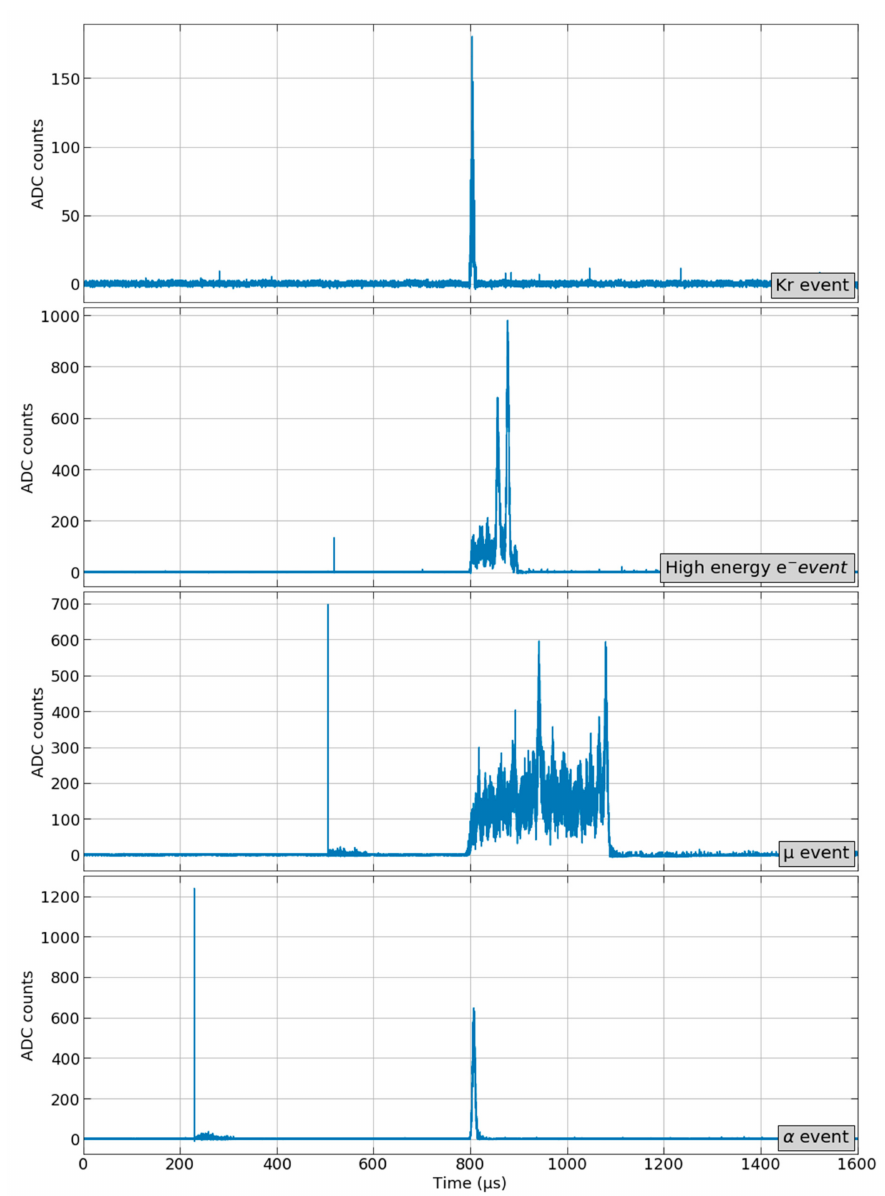
Figure 6. Set of events with a different range of energies from RUN 8250. General configuration: Circular Buffer size of 1600 µ s and pre-trigger of 800 µ s. EVT1 type set for low energy: Maximum amplitude of 1000 ADC counts, minimum and maximum amplitude thresholds of 5000 and 50,000 sum of ADC counts, and minimum and maximum time thresholds of 2 and 40 µ s. EVT2 type set for high energy: Maximum amplitude of 4095 ADC counts (maximum possible value), minimum and maximum amplitude thresholds of 50,000 and 16,777,215 (maximum possible value) sum of ADC counts, and minimum and maximum time thresholds of 2 and 600 µ